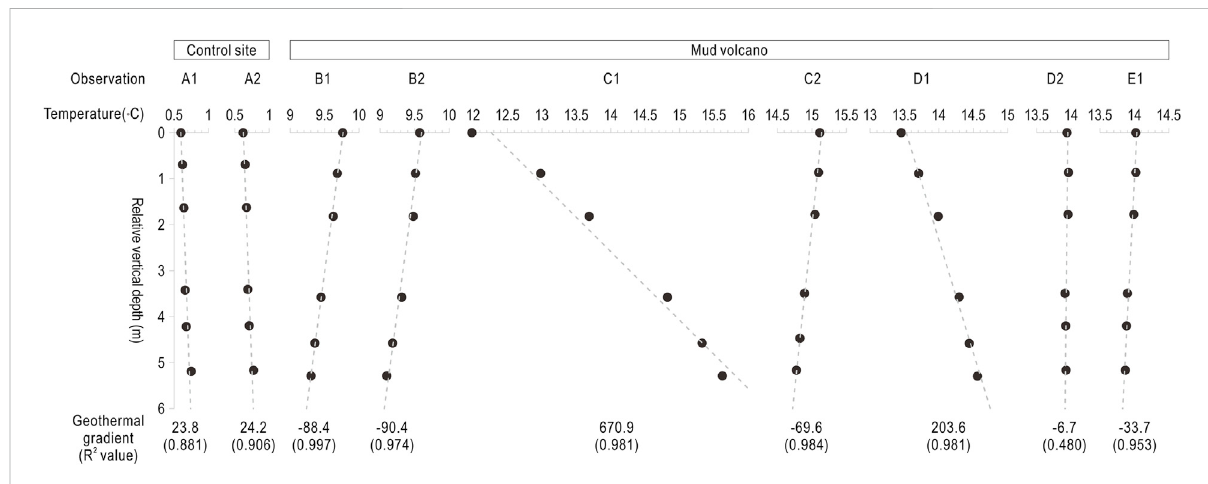
FIGURE 9 Observed results of temperature at depths (black dots) and geothermal gradient (dashed line) for Observations (A1 – E1) are plotted. Six MTLs penetrated the sediments for all observations. The scale for a horizontal temperature axis is the same through all the plots. The geothermal gradient (number) and the R2 value for linear regression (number in parentheses) are shown below the